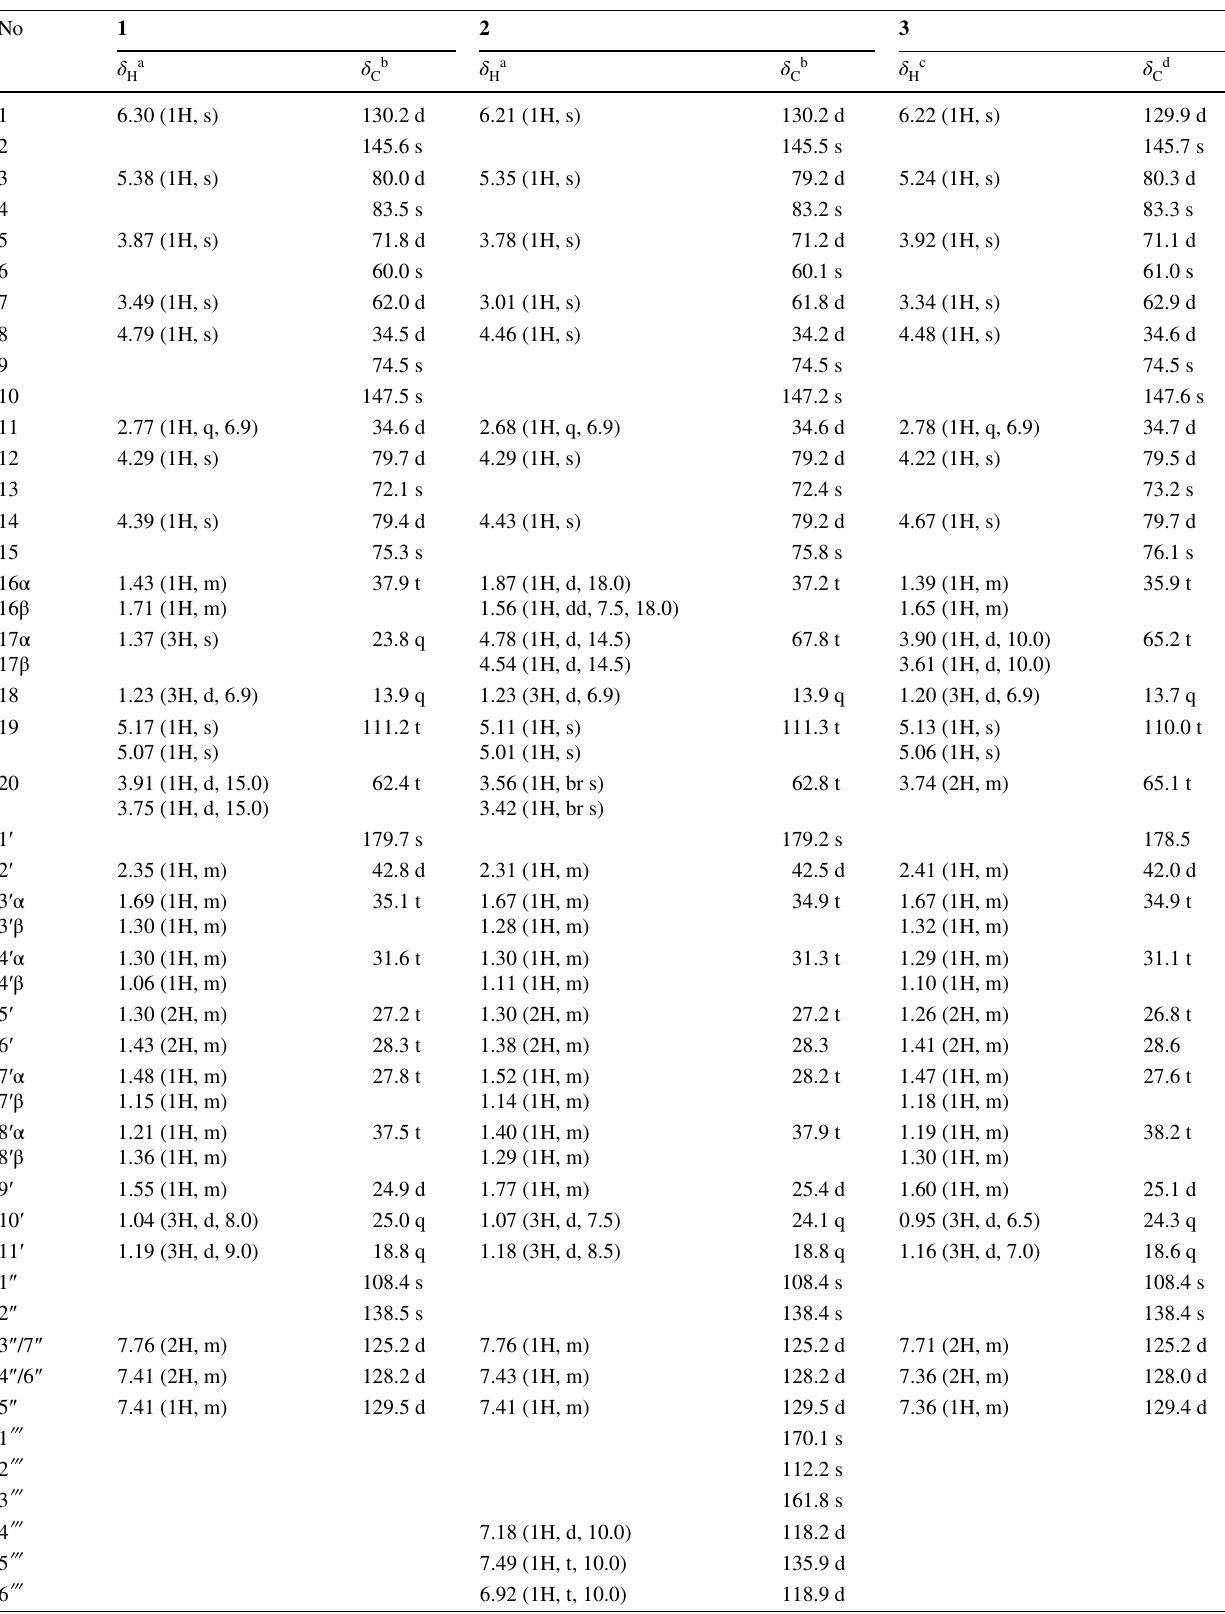
Table 1 1 H NMR and 13 C NMR Data of 1 –